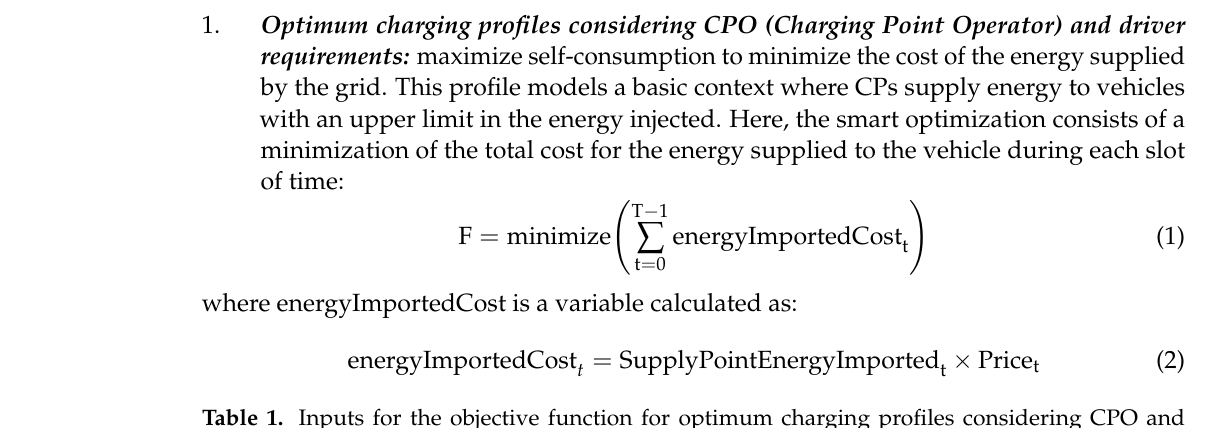
Table 1. Inputs for the objective function for optimum charging profiles considering CPO and driver requirements. Description